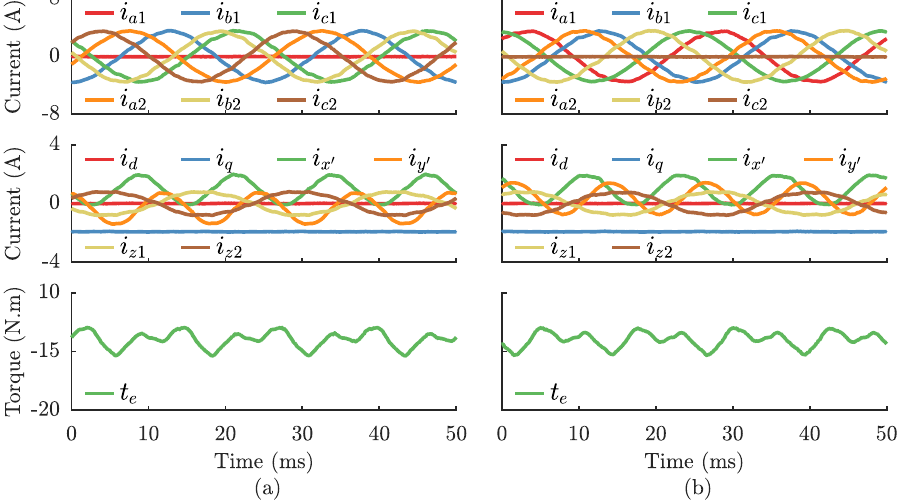
Figure 11. Experimental results for the six-phase drive under fault-tolerant mode, operating at